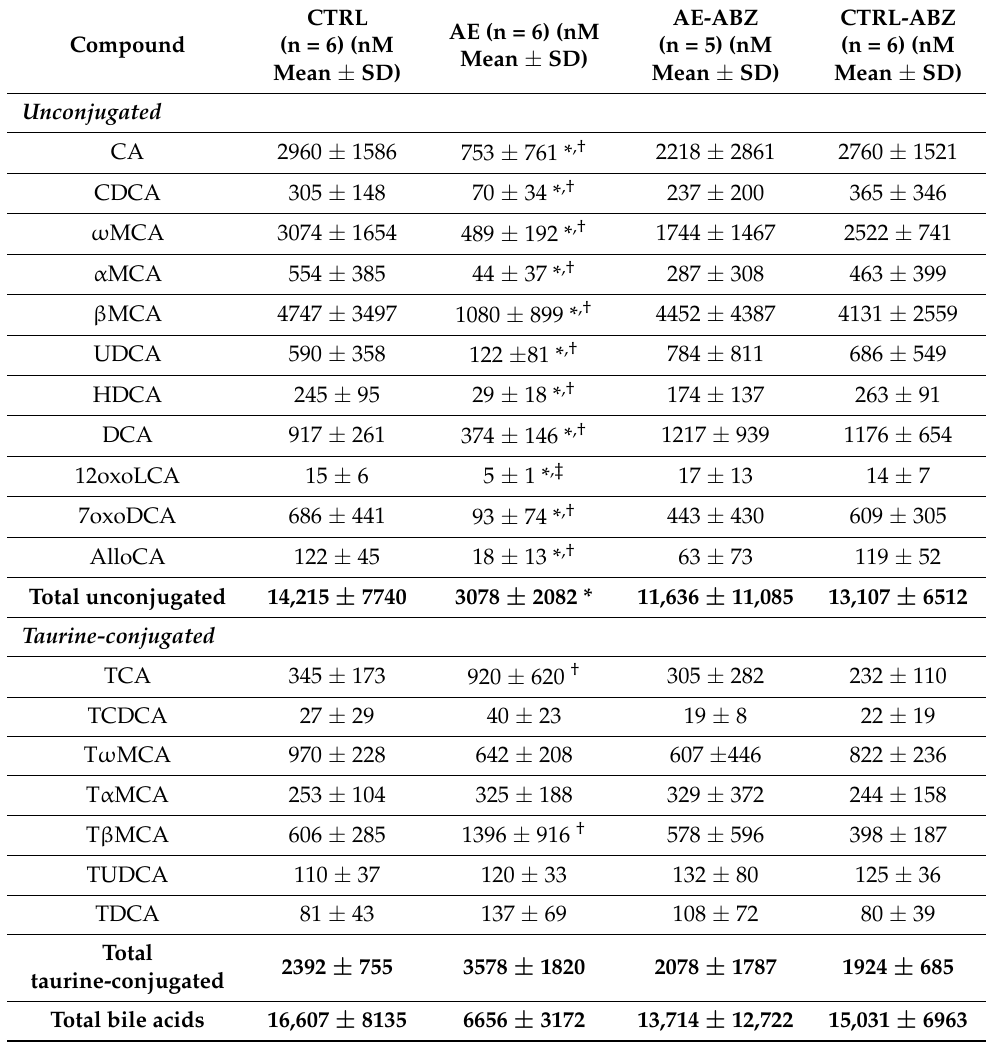
Table 1. Effects of E. multilocularis infection and ABZ treatment on bile acids in the serum of mice. The serum was collected from non-infected control (CTRL, n = 6), E. multilocularis -infected (AE, n = 6), E. multilocularis -infected and ABZ-treated (AE-ABZ, n = 5, one outlier with aberrant concentrations was removed), and non-infected and ABZ-treated control mice (CTRL-ABZ, n = 6). * p < 0.05 AE vs. CRTL, † p < 0.05 AE vs. CTRL-ABZ, and ‡ p < 0.05 AE vs. AE-ABZ. Values are expressed as mean ± SD (nM).